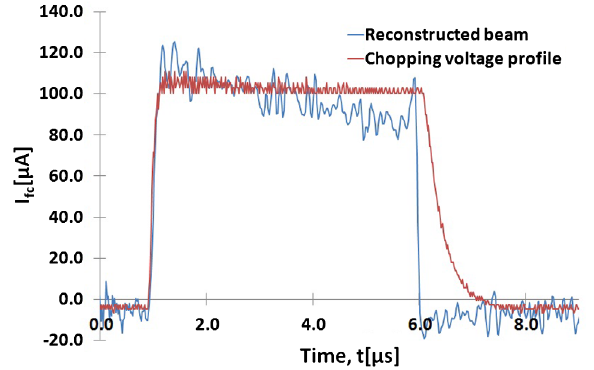
FIG. 21. Comparison of the reconstructed beam pulse with a duration of 5 (cid:1) s and the predicted beam profile.